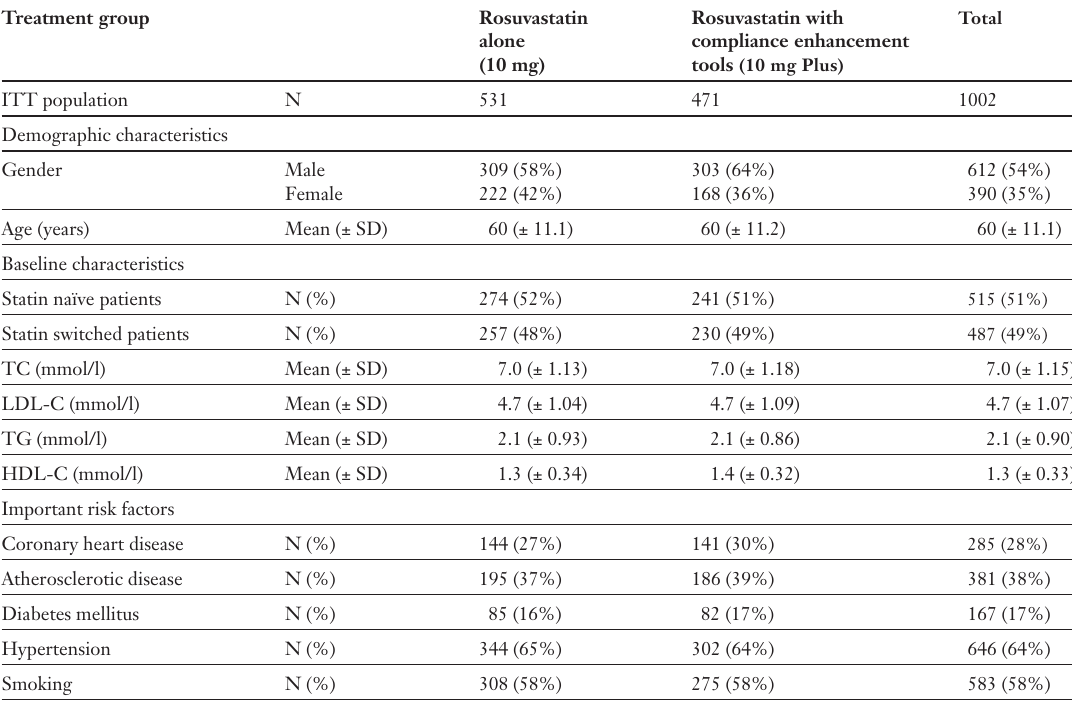
Demographic and baseline characteris- tics of the ITT popula-